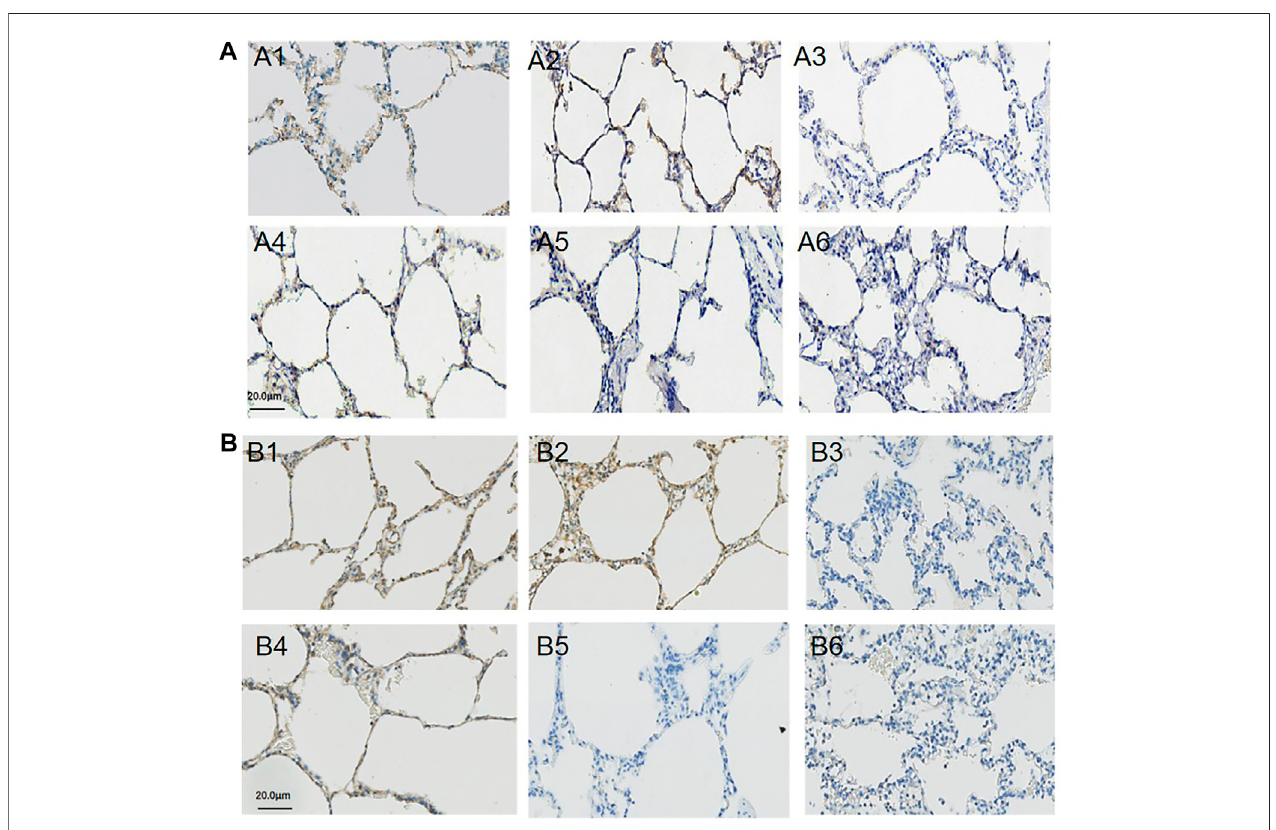
FIGURE 4 | Immunohistochemistry staining of E-cadherin and VE-cadherin. The expression and distribution of E-cadherin and VE-cadherin in the right lung were analyzed by immunohistochemistry staining. E-cadherin: lung tissues were obtained from the APRV group ( A1 : the upper lobe of lung; A2 : the middle lobe of the lung; A3 :thelowerlobeofthelung)andLTVgroup( A4 :theupperlobeofthelung; A5 :themiddlelobeofthelung; A6 :thelowerlobeofthelung)afterwholelungsalinelavage and 48 h of mechanical ventilation. VE-cadherin: lung tissues were obtained from the APRV group ( B1 : the upper lobe of the lung; B2 : the middle lobe of the lung; B3 :thelowerlobeofthelung)andLTVgroup( B4 :theupperlobeofthelung; B5 :themiddlelobeofthelung; B6 :thelowerlobeofthelung)afterwholelungsalinelavage and 48 h of mechanical ventilation. Brown means positive staining. Magni fi cation: ×400. APRV, airway pressure release ventilation; LTV, low tidal volume ventilation.